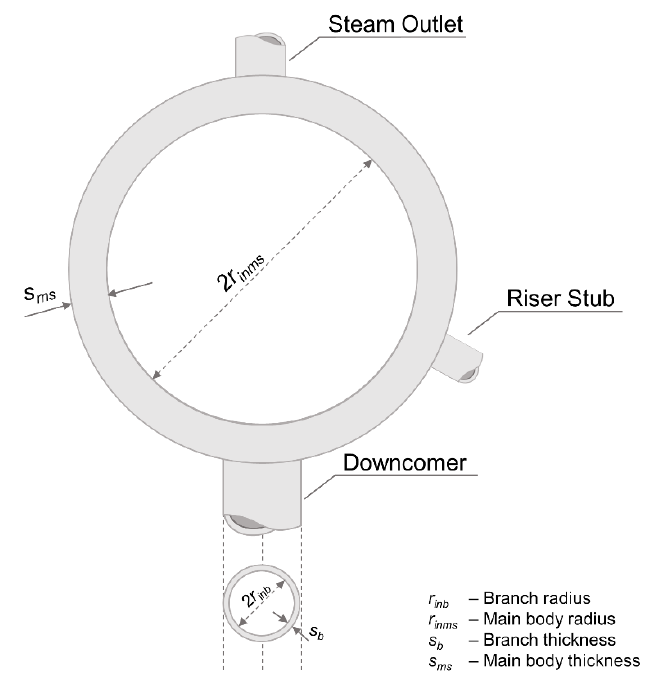
Figure 6. Diagram of a steam drum (including the drum–downcomer junction).